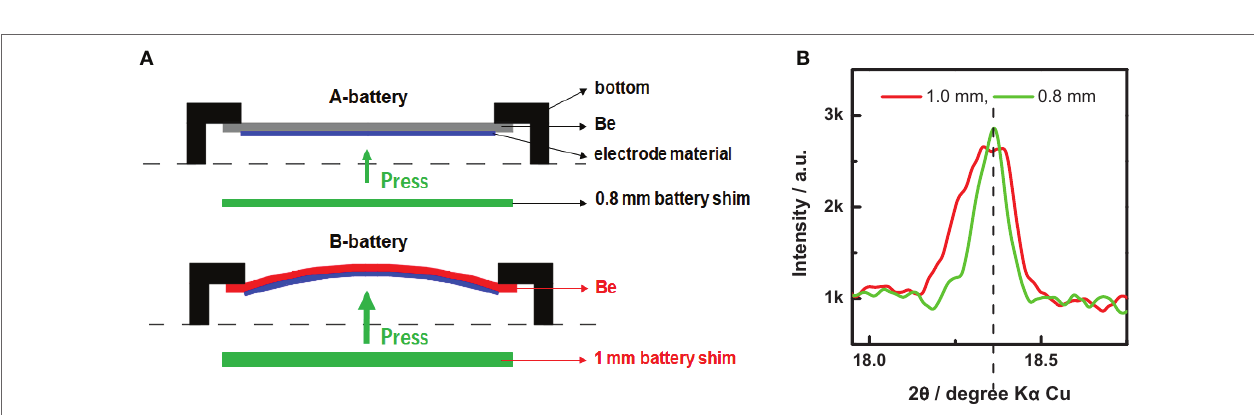
FigUre 3 | Influence of the electrode bending on X-ray diffraction (XRD) results. (a) Schematics of the flat and bent electrode films pressed on the Be sheets. (B) XRD patterns of Li 4 Ti 5 O 12 measured with two different in situ coin cells in (a)